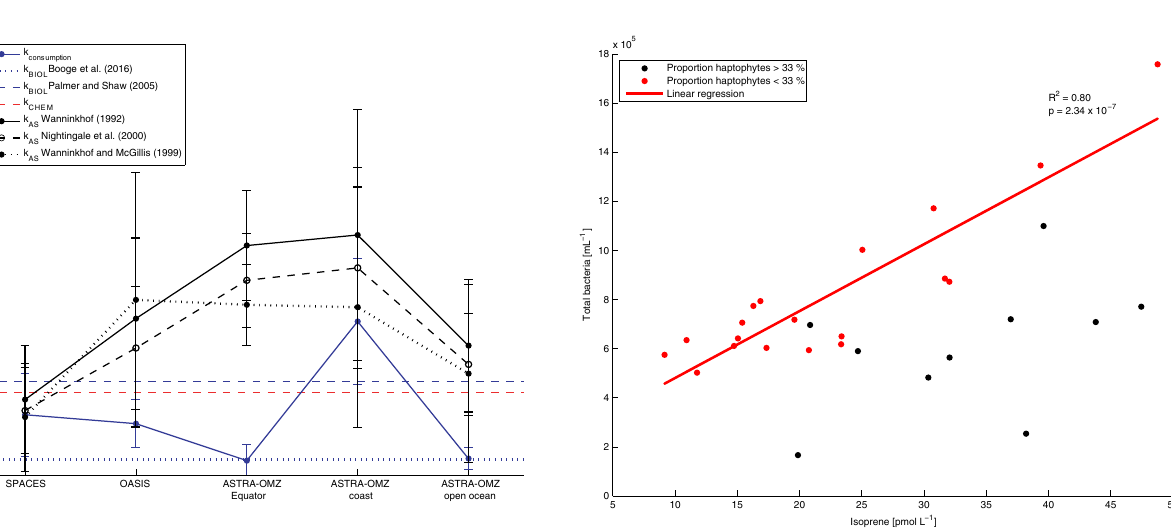
et al. (2016), whereas during ASTRA-OMZ (Equator